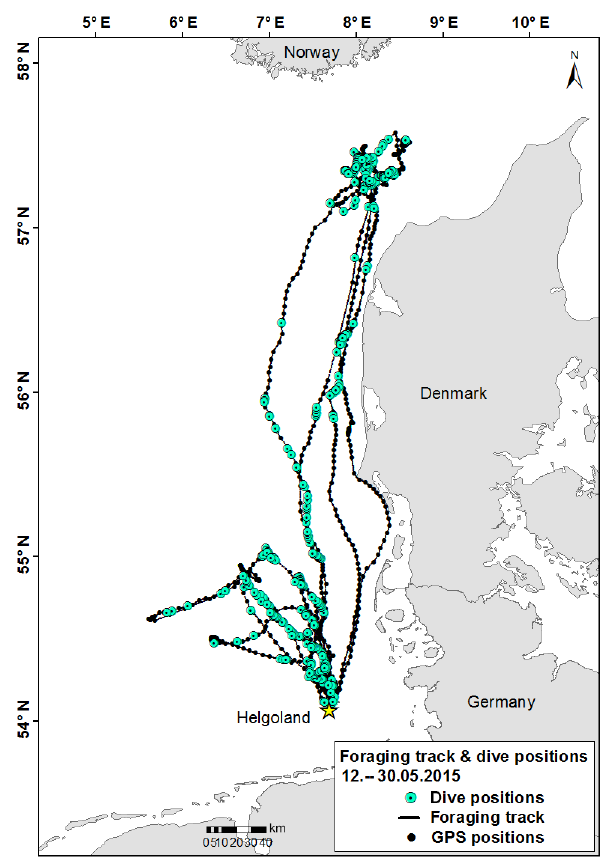
Figure 9. Foraging tracks and dive positions for the northern gannet shown in Fig. 3c. Please note that the data set is smaller than in Fig. 1c because only the synoptic GPS and pressure data are shown (the memory of the PTD logger was full after about 18